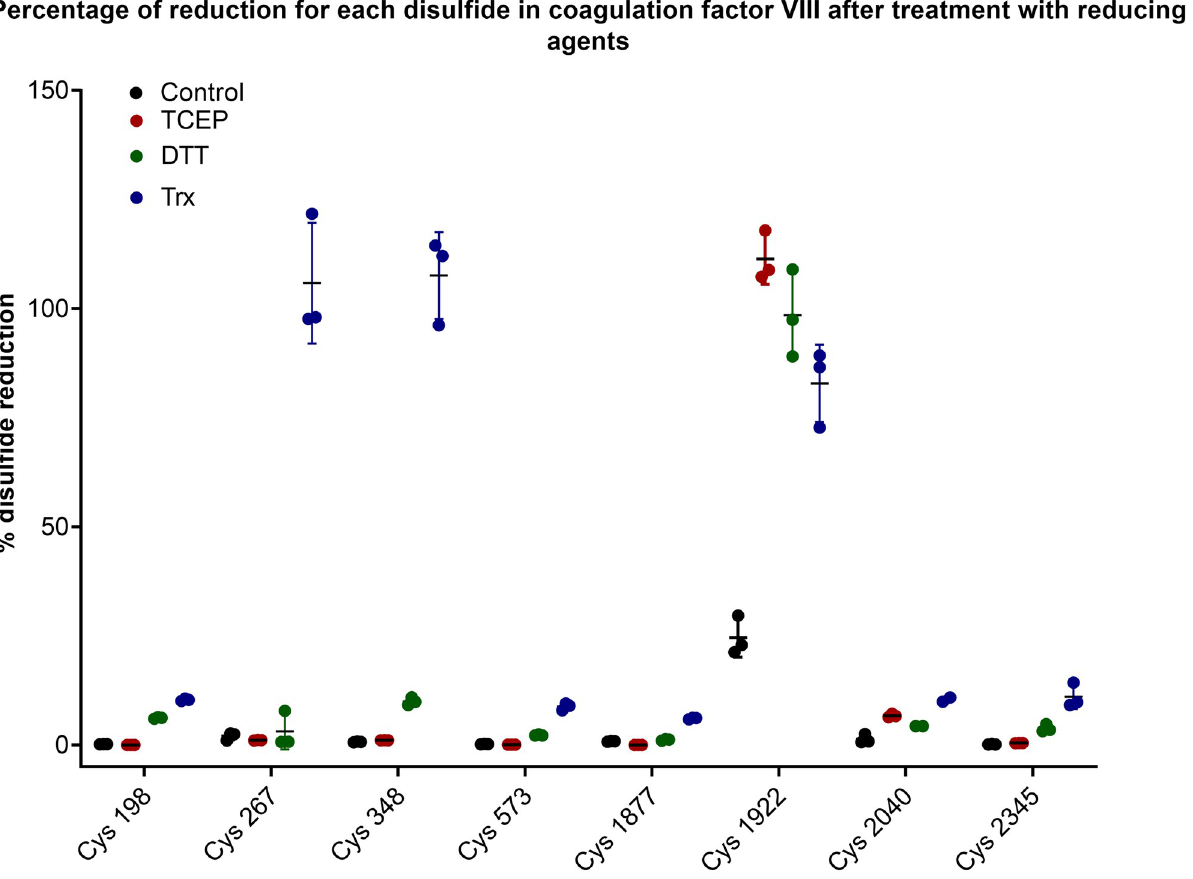
Fig 5. Experimental validation of in silico MD simulations by quantitative mass spectroscopy and ELISA. (A) Native or reduced (TRX 1) BDD rFVIII was alkylated with iodoacetamide (IAA) and subjected to tryptic digest and LC-MS/MS. Peak areas of IAA labelled cysteine peptides were compared to a control sample of BDD rFVIII which had been fully denatured, reduced and alkylated. The x-axis labels are as follows: cysteine 198 (from the Cys153-Cys179 bond); cysteines 267 and 348 (from the Cys248-Cys329 bond); cysteine 573 (from the Cys528-Cys554 bond); cysteine 1877 (from the Cys1832-Cys1858 bond); cysteine 1922 (from the Cys1899-Cys1903 bond); cysteine 2040 (from the Cys2021-Cys2169 bond) and cysteine 2345 (from the Cys2174-Cys2326